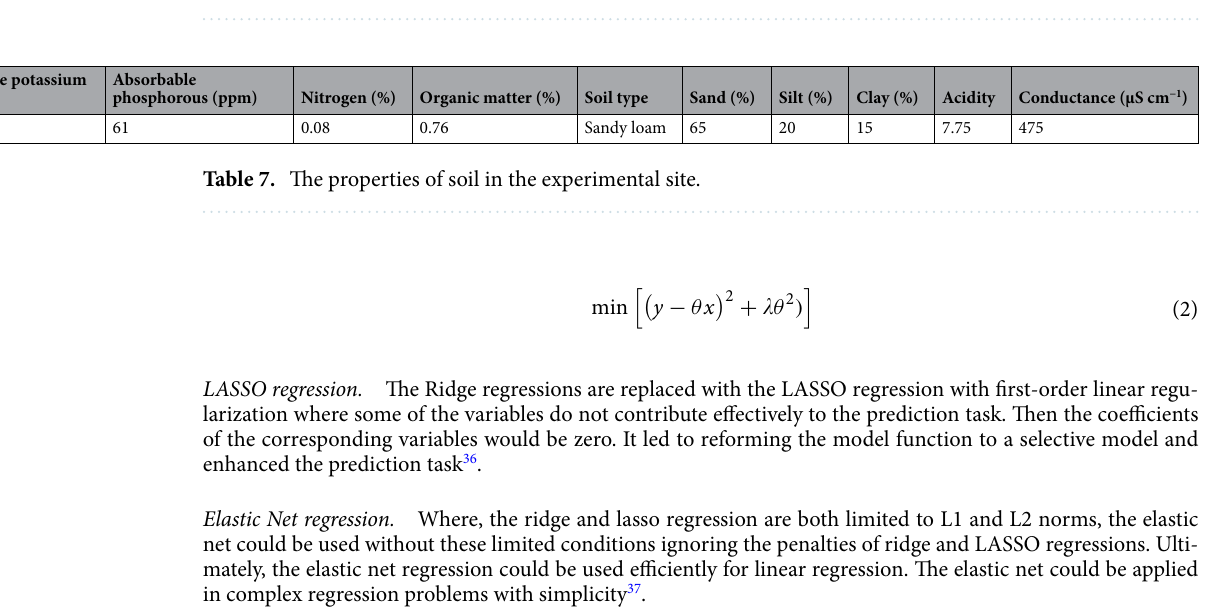
Figure 7. The schematic of the methodology has been implemented to study Balangu’s agronomic properties.